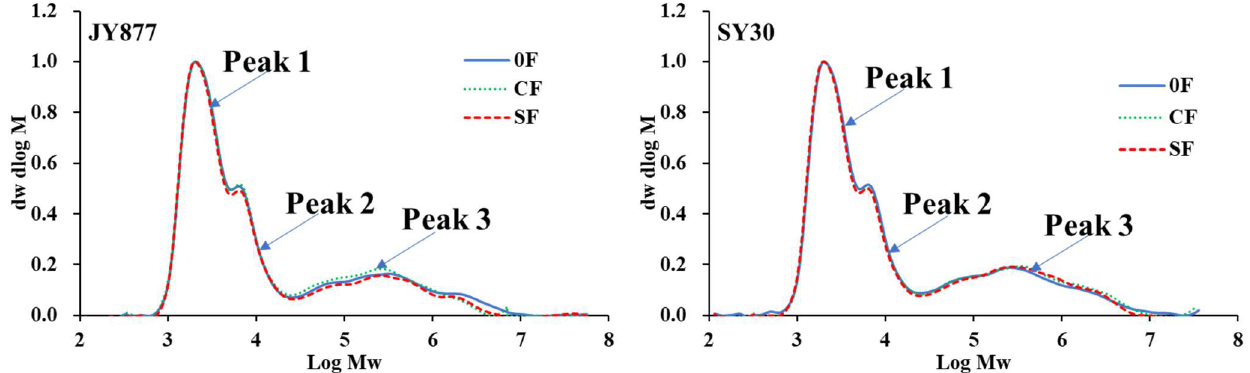
Figure 2. Effects of the fertilization mode on isoamylase-debranched starch GPC profiles of normal maize. JY877, Jiangyu877; SY30, Suyu30; 0F, zero fertilization; CF, common fertilization; SF, slow- release fertilization.